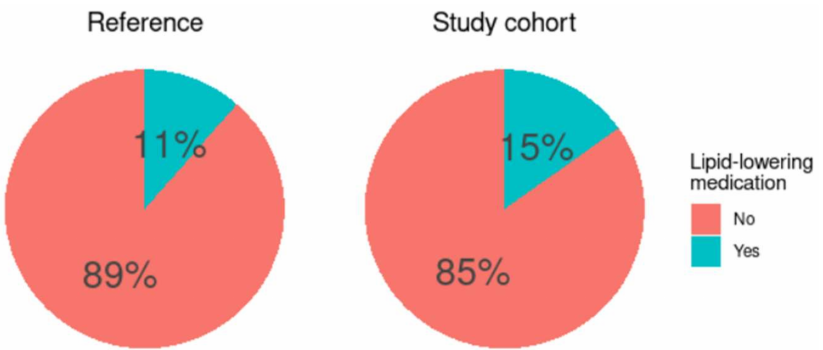
Figure 6. Comparison of the usage of lipid-lowering medication between the study cohort and a reference